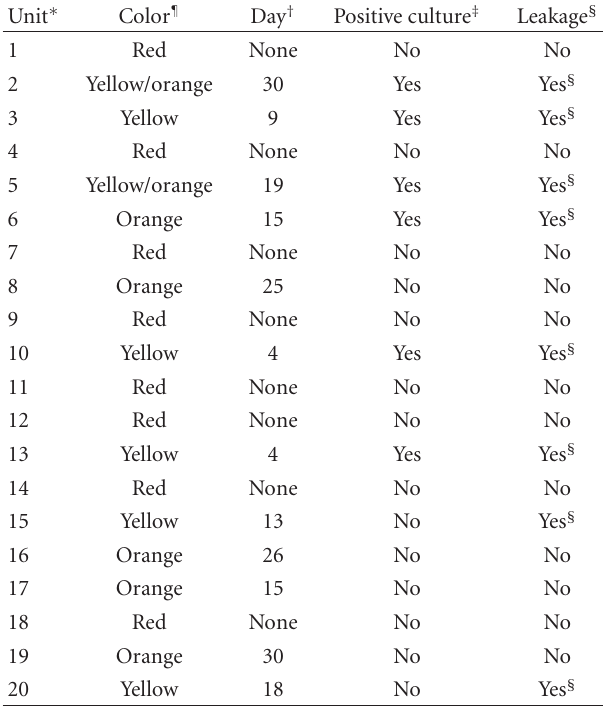
Table 1: Color change and culture findings from lower chamber in AH26